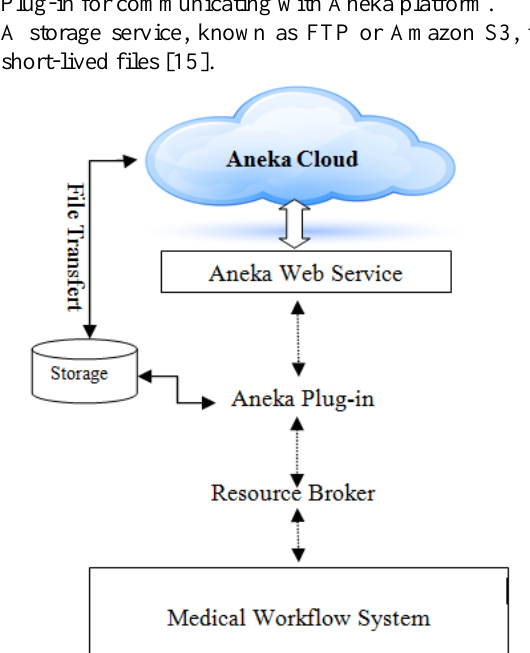
Fig. 2. Architecture implemented design shows that the growth of software use in healthcare increases the need for designing and developing the accurate system and requires finding particular tools for designing appropriate architectures of cloud-based medical workflow